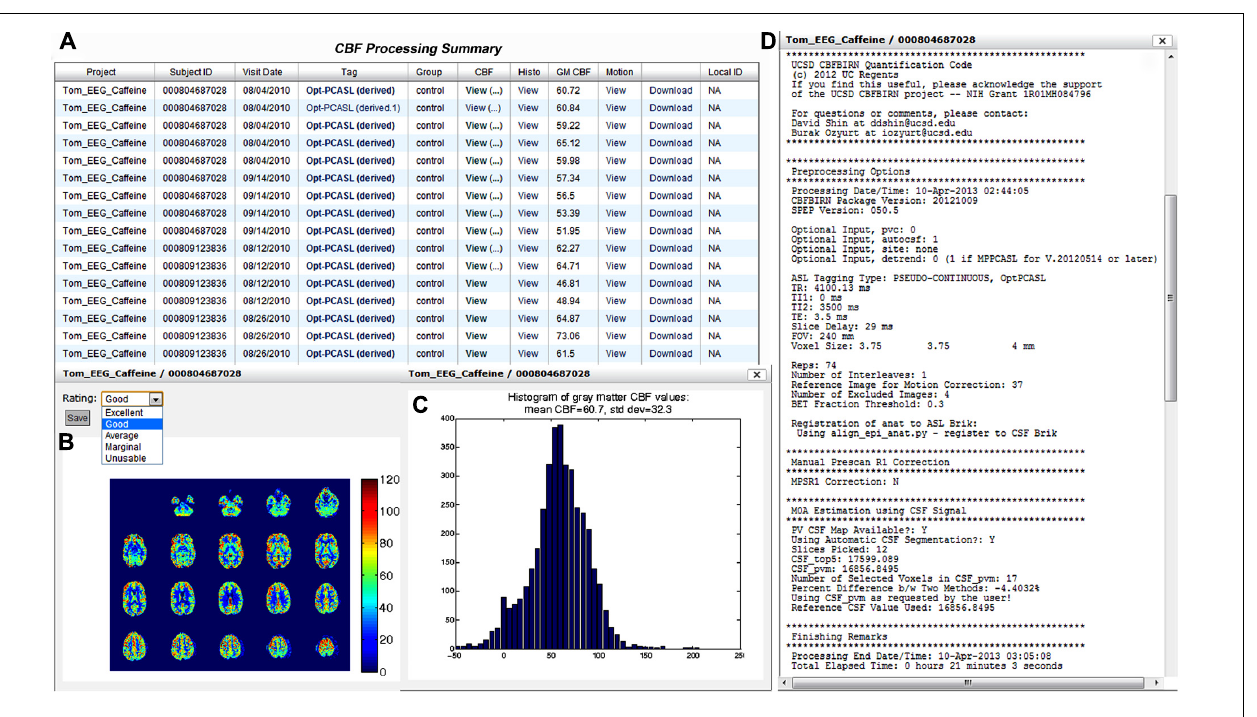
protocol, and whole-brain mean gray matter CBF value. A CBF map (B) , a histogram of gray matter CBF values (C) , and detailed processing logs (D) are shown from a representative job, all of which are accessible directly from the